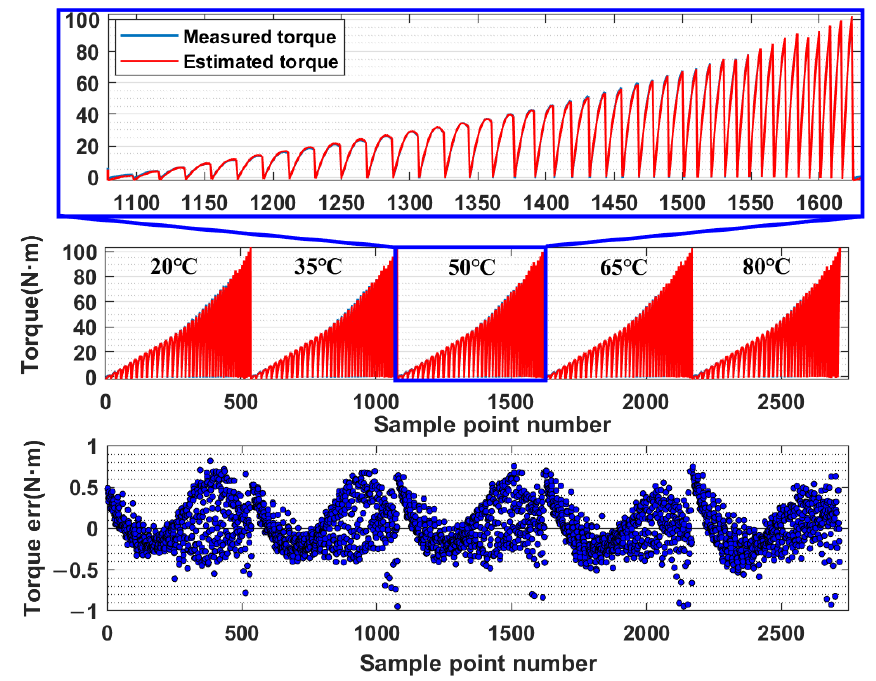
Figure 20. Error of wide temperature torque model.